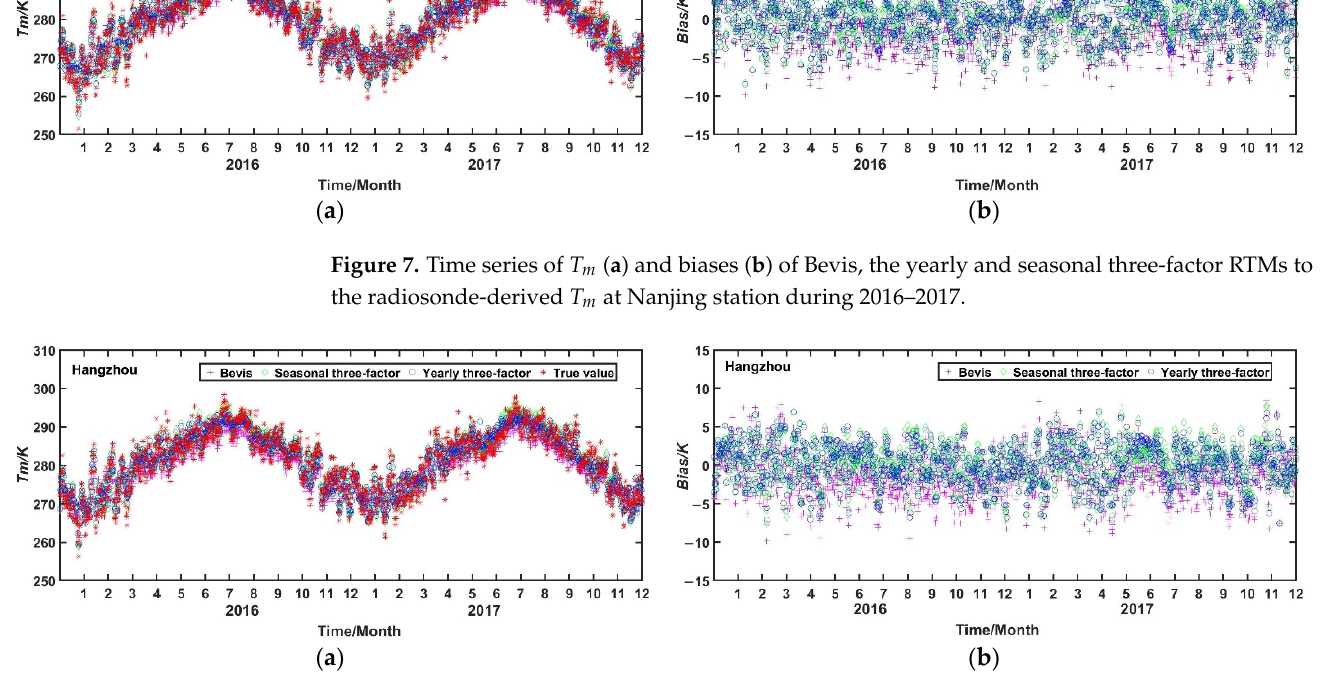
Figure 8. Time series of 𝑇 (cid:3040) ( a ) and the biases ( b ) of Bevis, the yearly and seasonal three-factor RTMs to the radiosonde-derived 𝑇 (cid:3040) at Hangzhou station during 2016–2017.